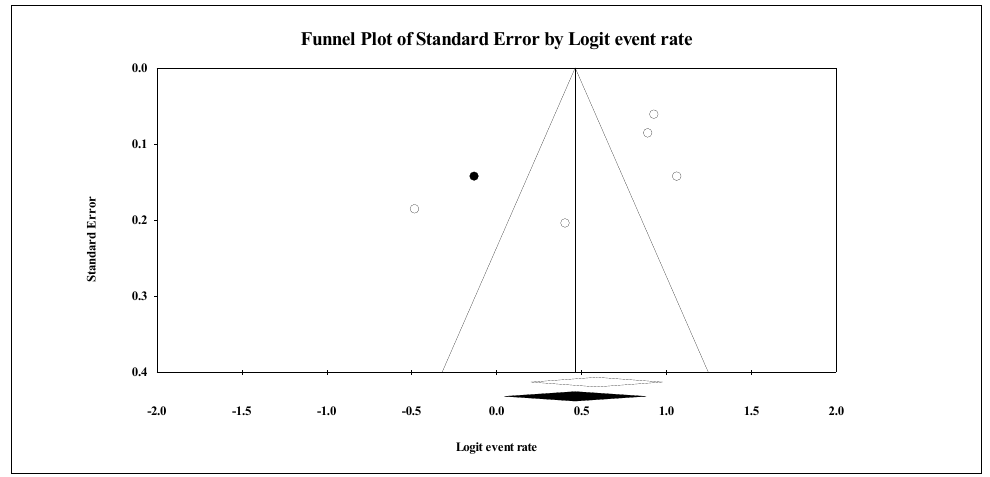
Figure A10. Funnel plot for studies on the prevalence of impaired sleep quality (Egger test: P = 0.22; Begg test: P = 0.22). The vertical solid line represents the summary effect estimates.